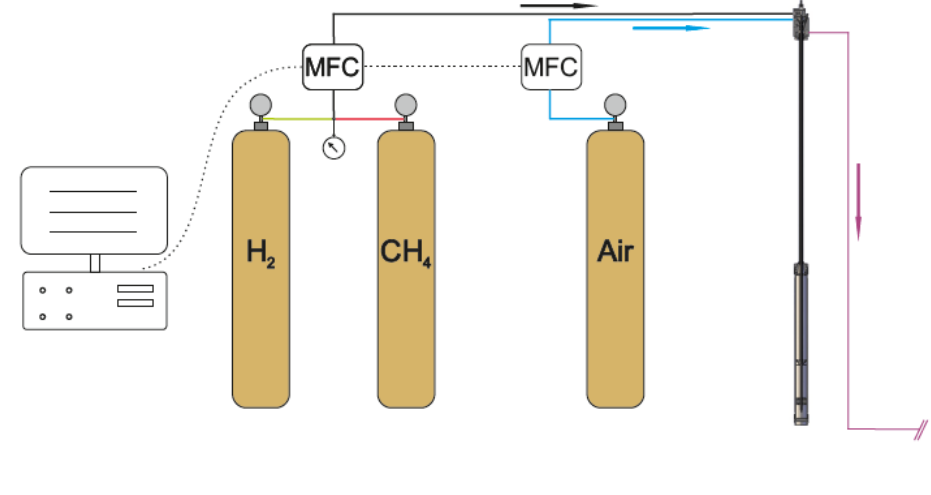
Figure 12. Sketch of the gas supply for the reactor. Black line = fuel gas (H line = air; purple line = exhaust